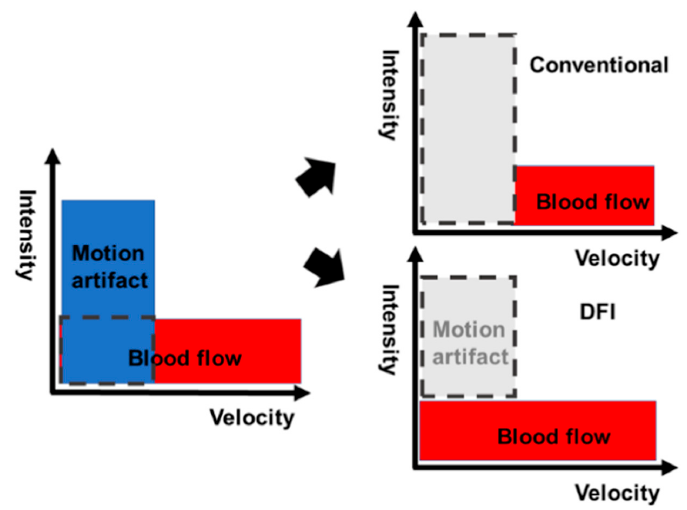
Figure 2. Conventional Doppler and DFI images. When conventional Doppler techniques remove motion artifacts with a single-dimensional wall filter, not only overlaying tissue motion artifacts but also the low-flow component are removed. Consequently, the visibility of flow in smaller vessels is lost due to loss of low-flow data. On the other hand, DFI can separate flow signals from motion artifacts with a multi-dimensional filter, which analyzes motion artifacts and uses an adaptive algorithm to identify and remove tissue motion. Therefore, DFI overcomes this loss of low-flow signals by separating them from overlapping tissue motion artifacts without jeopardizing the visualization of low-flow components and, in addition, provides detailed vessel signals.